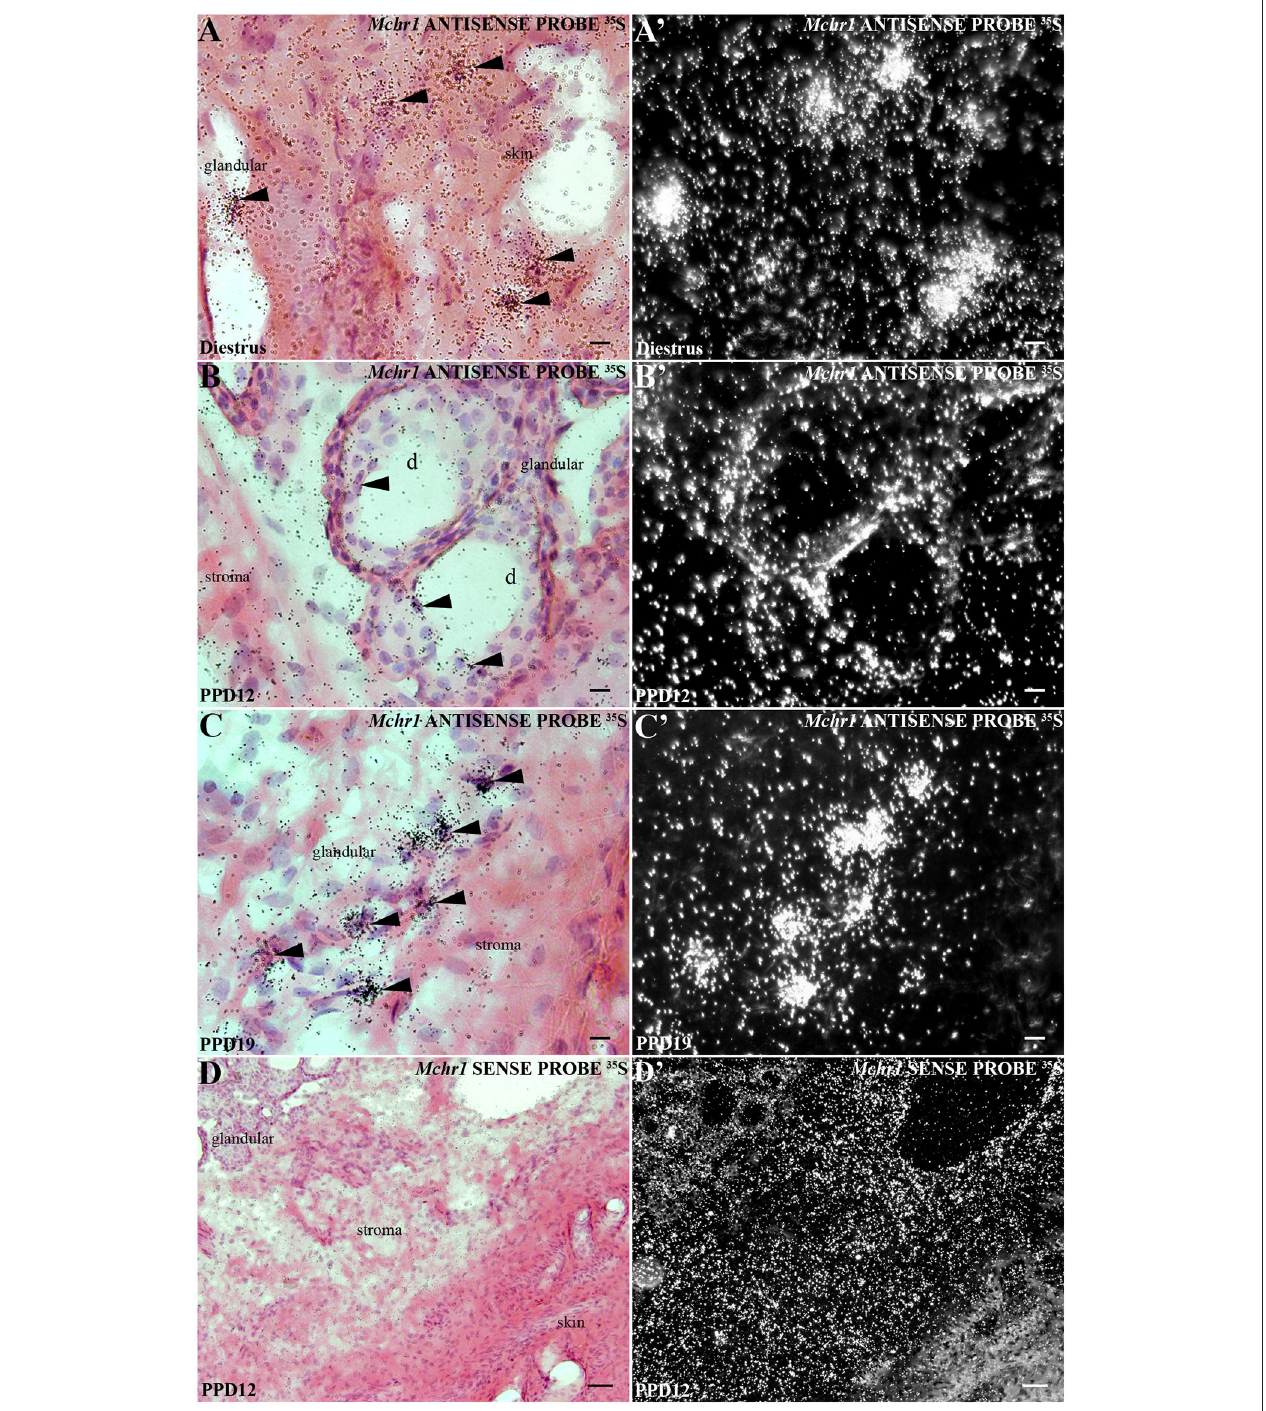
FIGURE 1 | Distribution of Mchr1 mRNA in the rat mammary gland tissue. A series of bright field photomicrographs showing Mchr1 mRNA (silver grains) over hematoxylin-eosin-counterstained cells in the mammary gland tissue (skin and undifferentiated parenchyma) of (A) diestrus female rat, (B) PPD12, and (C) PPD19 dams, ( n = 3/group). Dark field photomicrographs of (A’- C’) display that the mammary gland tissue of diestrus female rat (A’) presents a restricted Mchr1 mRNA expression in skin and, the lactating dams in PPD12 (B’) and PPD19 (C’) present a parenchyma expression: acini and stroma. A series of bright field (D) and dark field (D’) photomicrographs showing no labeled cells hybridized in the mammary gland tissue of lactating dam in PPD12 when cRNA Mchr1 sense probe was applied. The Mchr1 mRNA cells are indicated by black arrowheads. d, duct. Scale bars: 10 µ m (A–C) , 10 µ m (A’–C’) , and 50 µ m (D, D’) .